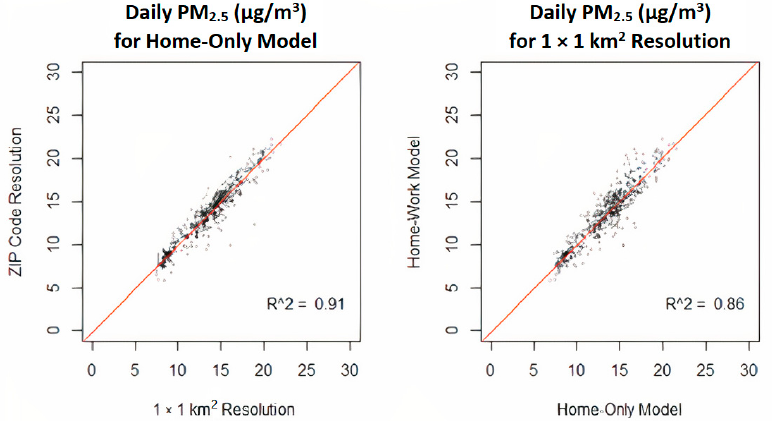
(ranging from 0.85–0.96). Figure 6 presents an example for one of these paired comparisons.